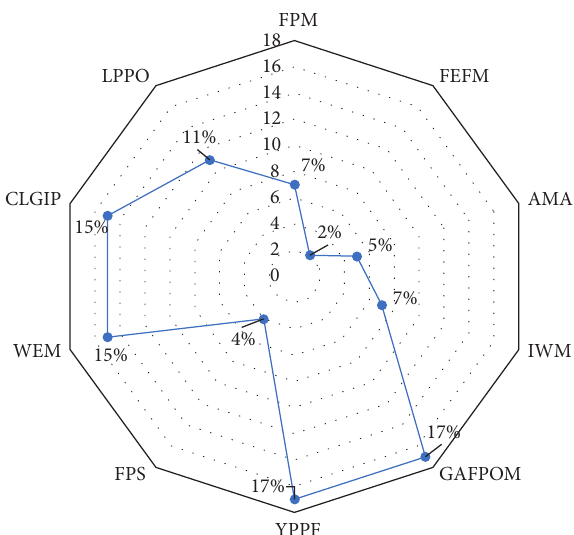
Figure 6: Percentage technology convergence in agriculture and food systems.